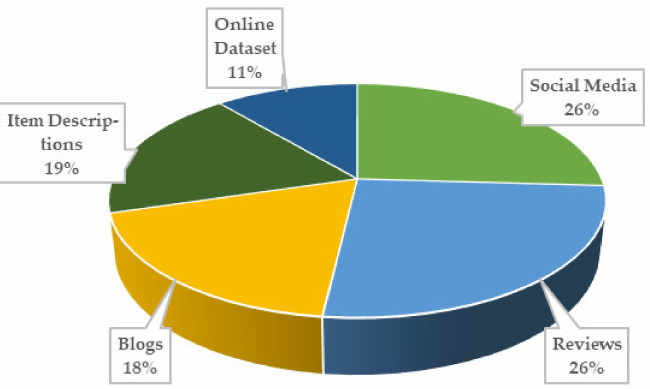
Figure 7. Distribution of data sources used in the articles listed in Table 3, selected via the search criteria related to Text Mining and Apparel Industry.